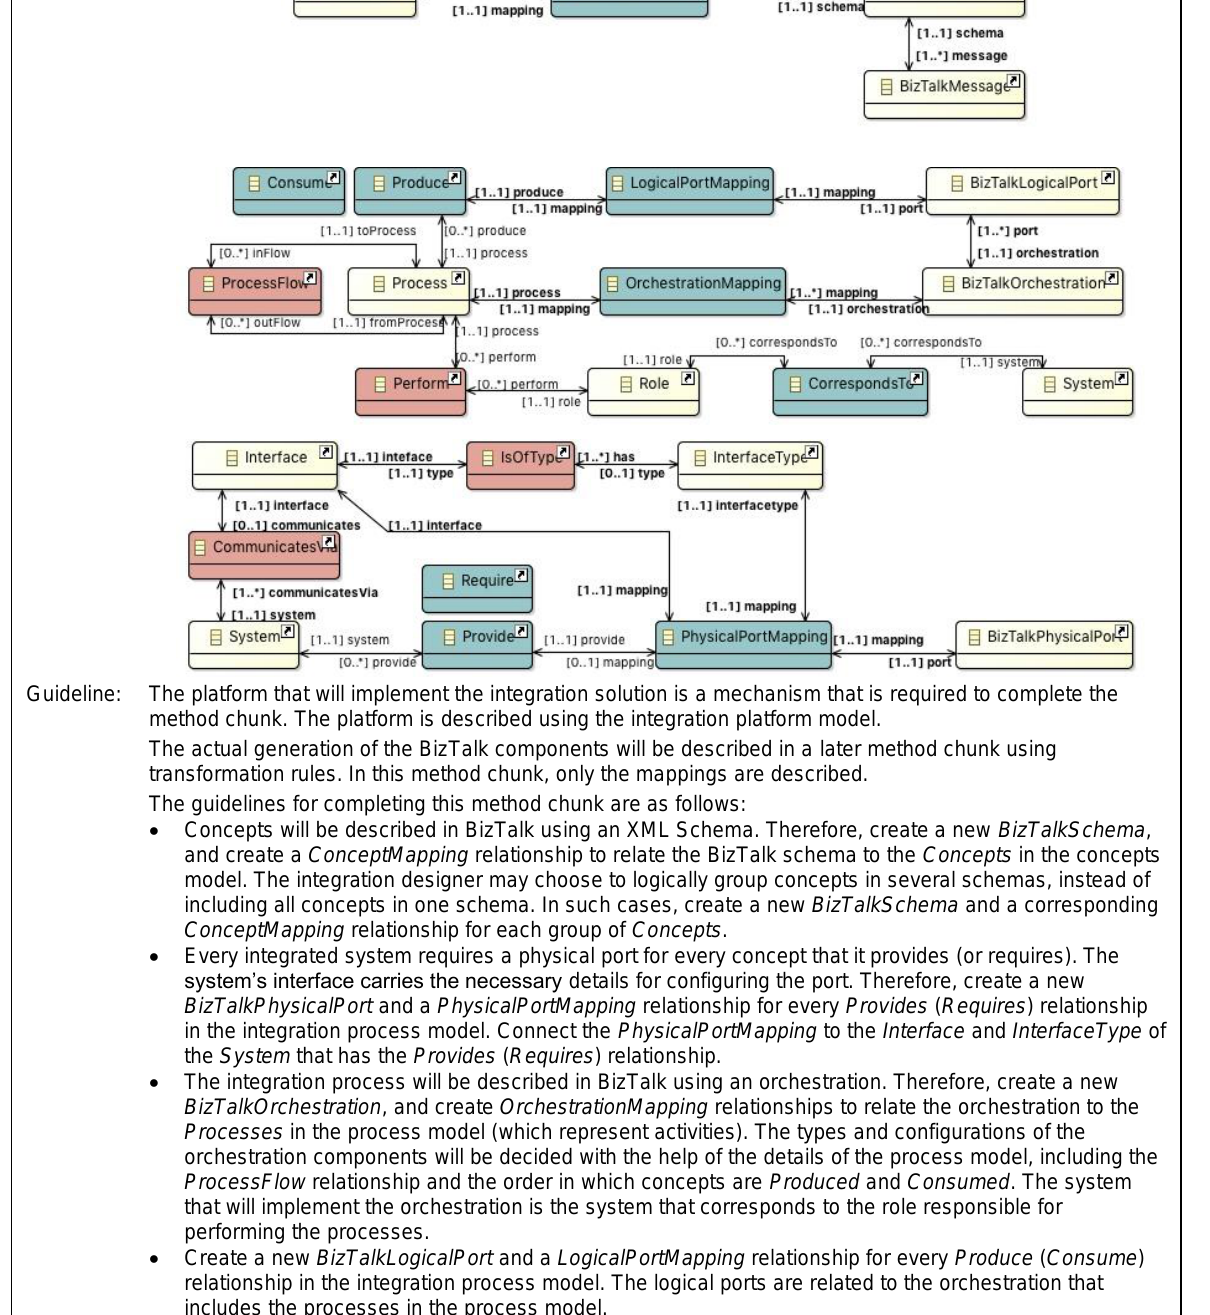
integration design modeling components to the integration platform’s architectural